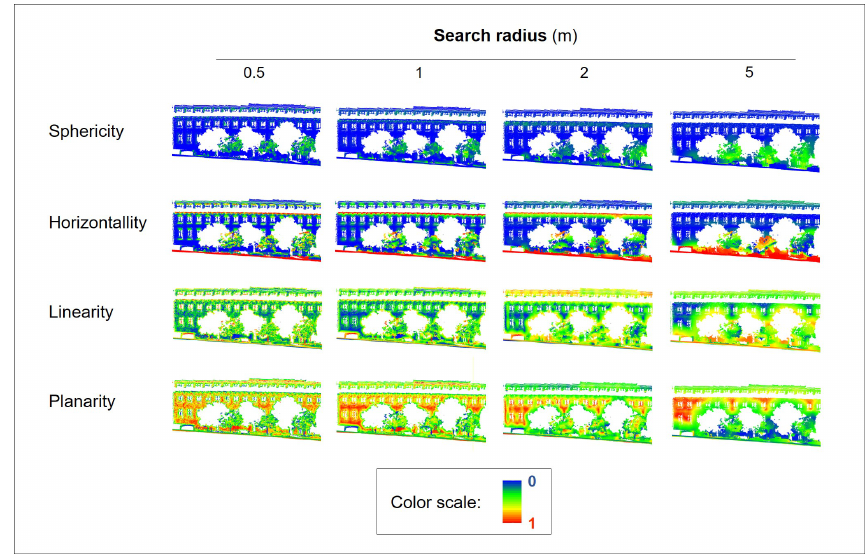
Figure 8. Example of the features extracted at different scales.